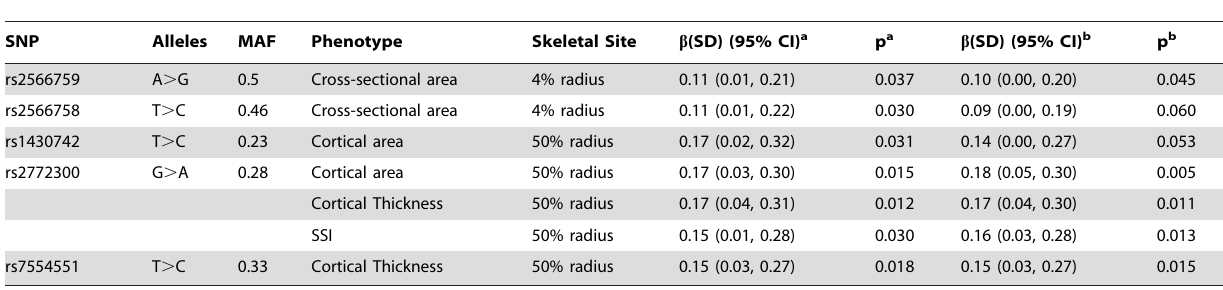
Table 4. GPR177 SNP associations with radius geometric parameters.